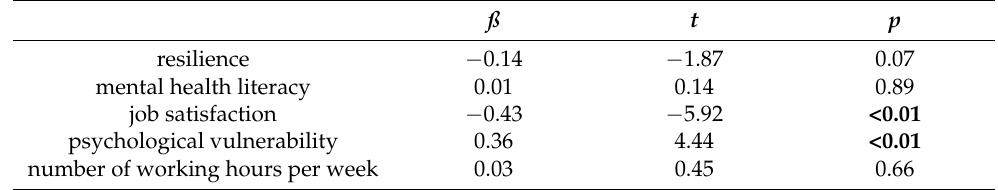
Table 5. Influence of the potential protective and vulnerability factors on municipal workers’ burnout. ß t p resilience − 0.14 − 1.87 0.07 mental health literacy 0.01 0.14 0.89 job satisfaction − 0.43 − 5.92 <0.01 psychological vulnerability 0.36 4.44 <0.01 number of working hours per week 0.03 0.45